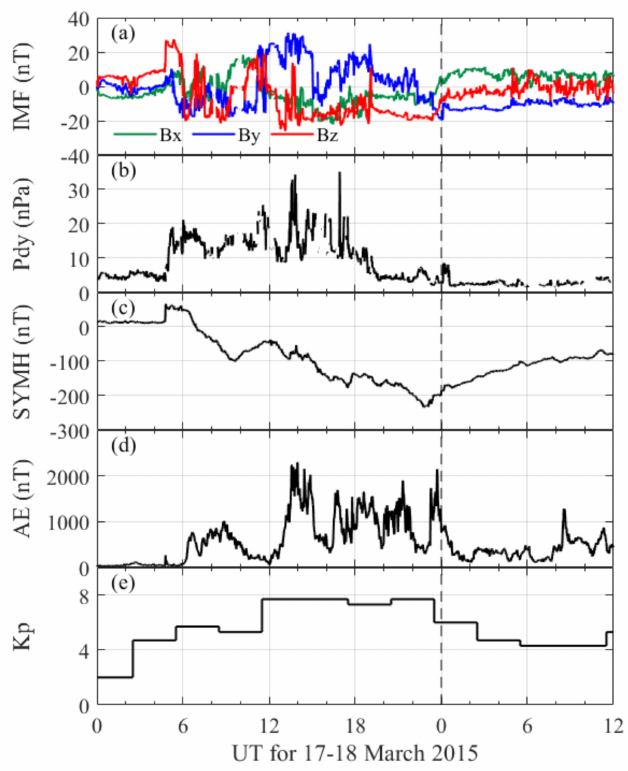
Figure 1. Solar geophysical conditions for 17–18 March 2015. ( a ) IMF B x , B y and B z (nT) in GSM coordinates; ( b ) solar wind dynamic pressure P dy (nPa); ( c ) SYM-H index (nT); ( d ) AE index (nT); ( e ) Kp